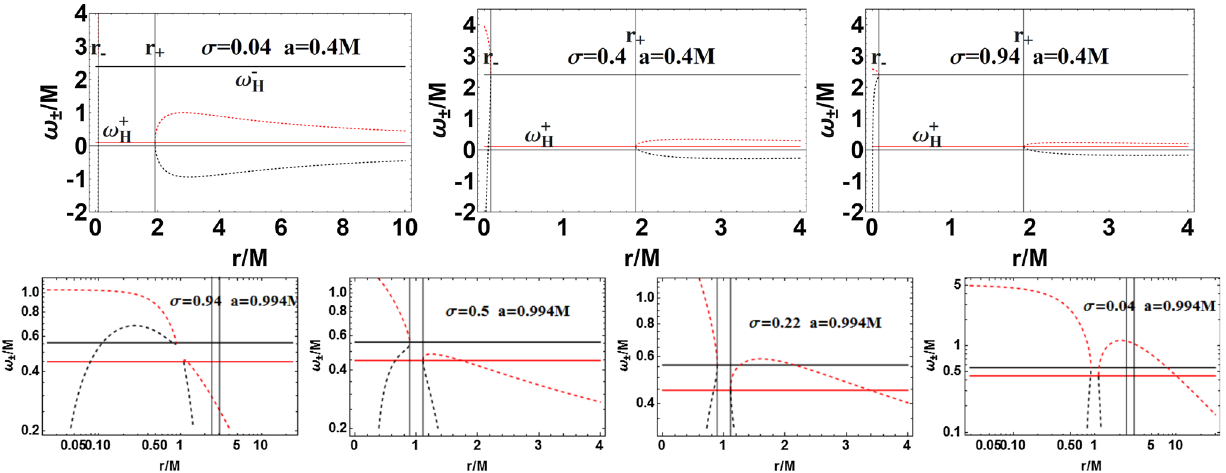
Fig. 14 Frequencies ω ± for different spins a / M and planes σ , as functions of r / M . The horizontal lines are horizon frequencies ω ± are the inner and outer horizons r ± . There are solutions ω = ω ±